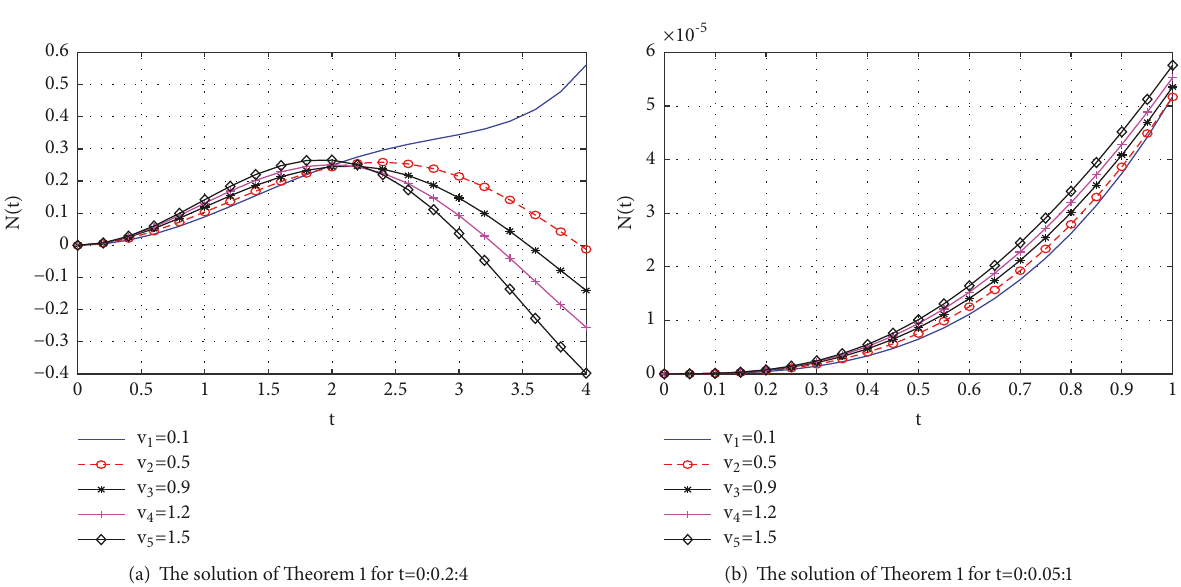
Figure 2(b) is based on assignment for the parameters 𝑁 0 = 10, 𝑐 = 1, 𝑞 = 2, 𝜆 = 7, 𝜇 = 7, 𝑚 = 4, 𝜂 = 7, 𝑏 = 7 , 𝑑 = 3 . Figure 3(a) is the graphical solution of Theorem 3 using the assignment on the parameters 𝑁 0 = 1, 𝑐 = 1, 𝑞 = 1, 𝜆 = also Figure 3(b) is based on assignment for the